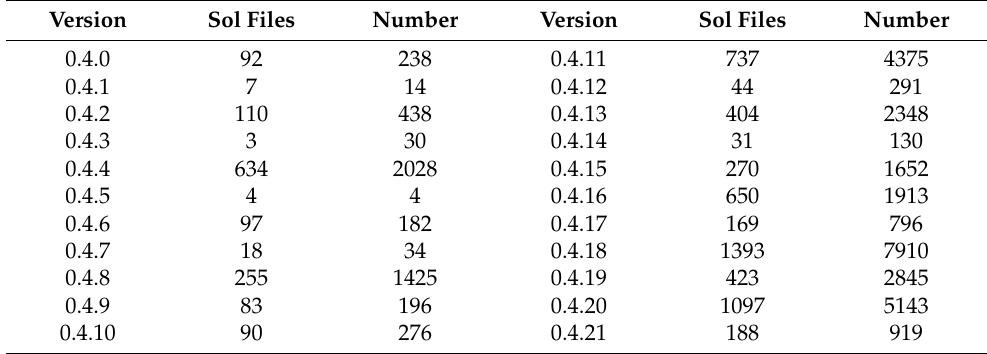
Table 2. Distribution of raw data of smart contracts.